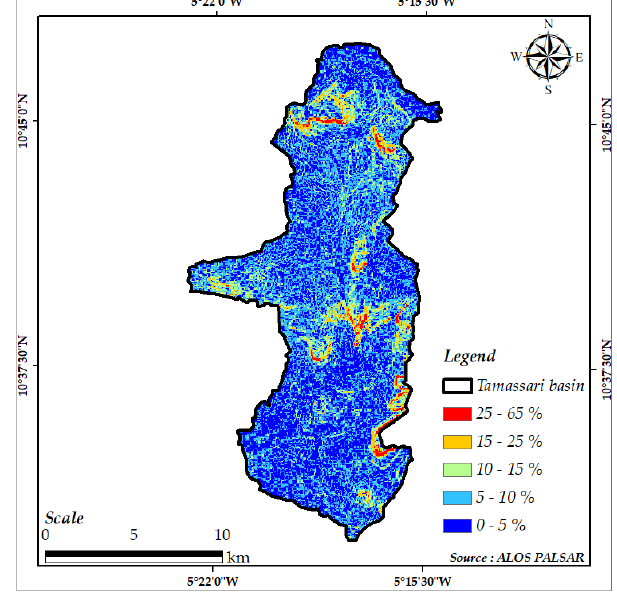
Figure 9. Hydrographic network density mapping.